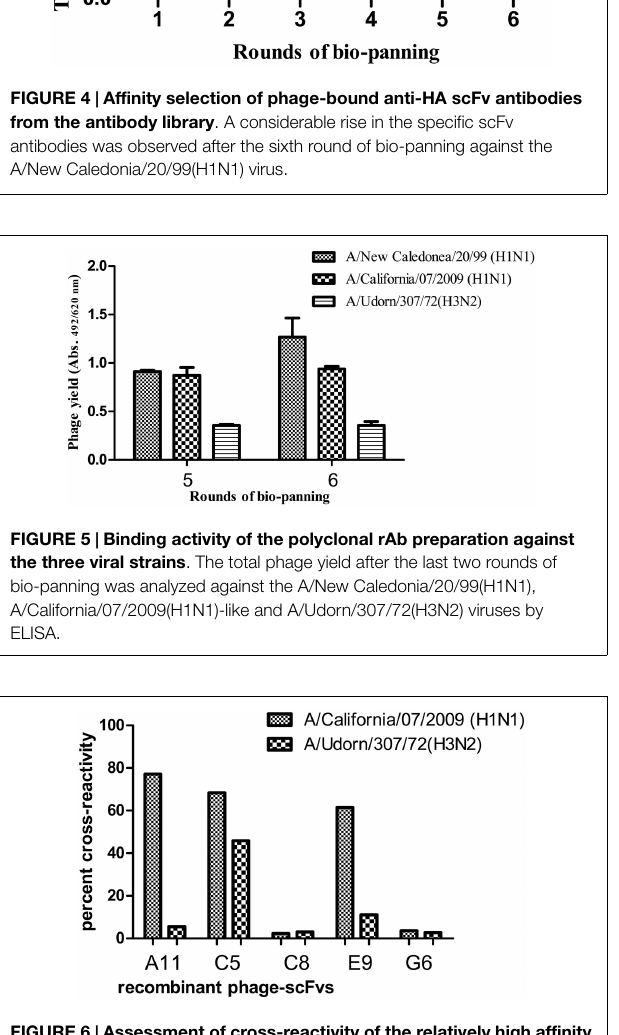
sequences of Nco I (5 ′ ) and Hin dIII (3 ′ ) were added to the ampli- fied heavy chain gene fragments and Mlu I (5 ′ ) and Not I (3 ′ ) to the amplified light chain gene fragments. The choice of restriction enzymes was based on various advantages offered by them, viz.